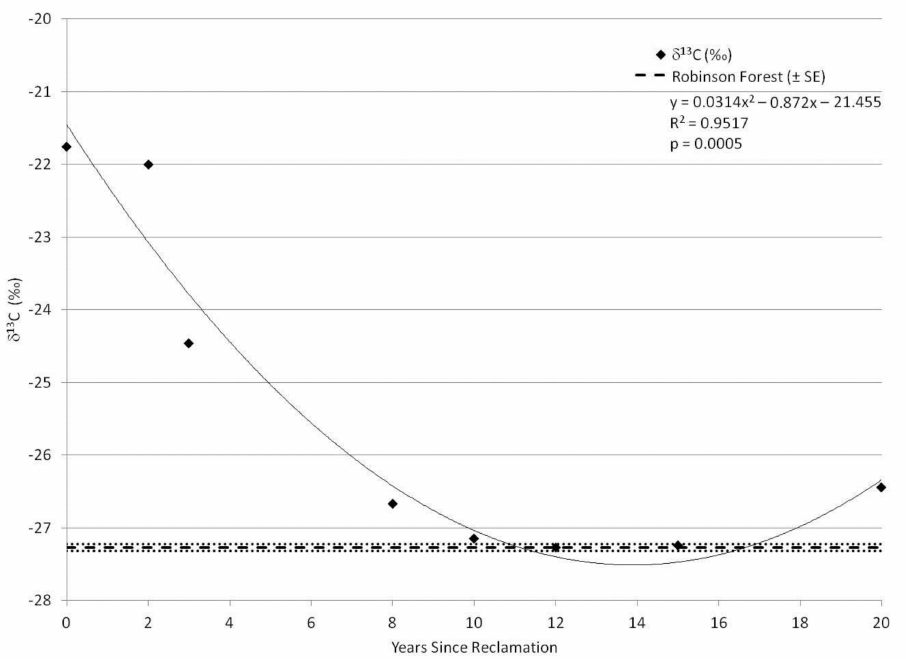
Figure 6. Changes in δ 13 C ( ‰ ) in mine soils over time since reclamation, with mean δ 13 C ( ± SE) for soil from a mature white oak stand in Robinson Forest plotted for reference.